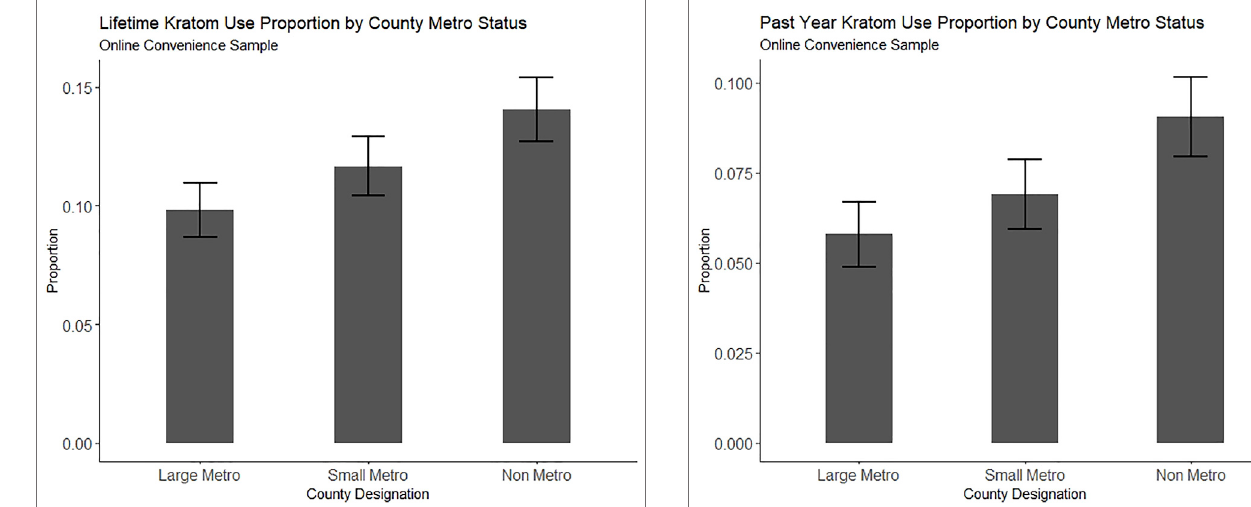
FIGURE 2 | Proportion of people reporting past-year kratom use in an online convenience sample (N (cid:1) 2,615), split by county metro status. Error bars represent the estimate 95% con fi dence